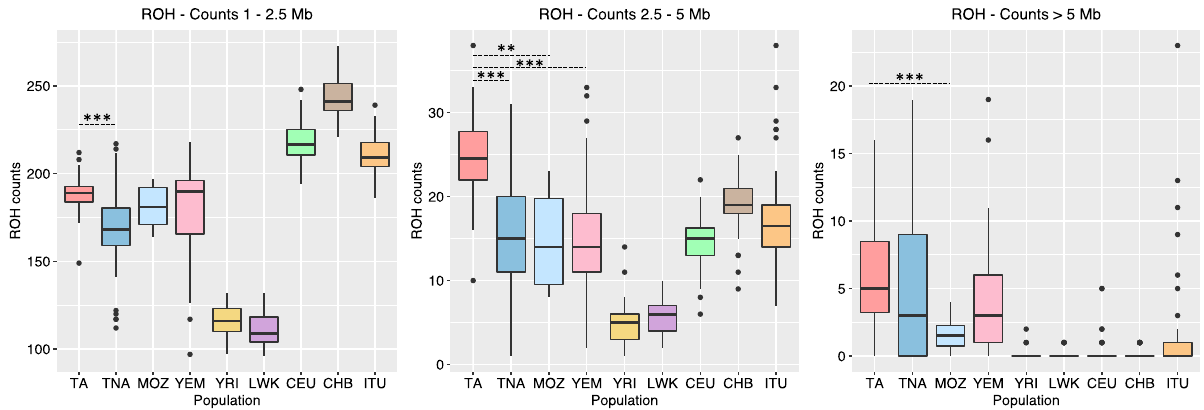
Figure 3. Per-individual counts of runs of homozygosity in different length categories. Boxplots indicate the distribution of the per-individual number of runs of homozygosity in different populations. Points indicate outlier individuals. Dashed lines indicate a statistically significant t-test between Tunisian Imazighen and other North African and Middle Eastern populations. Statistical significance is shown in the following way: * p < 0.05, ** p < 0.01, *** p < 0.001. Population names abbreviated as in Fig.